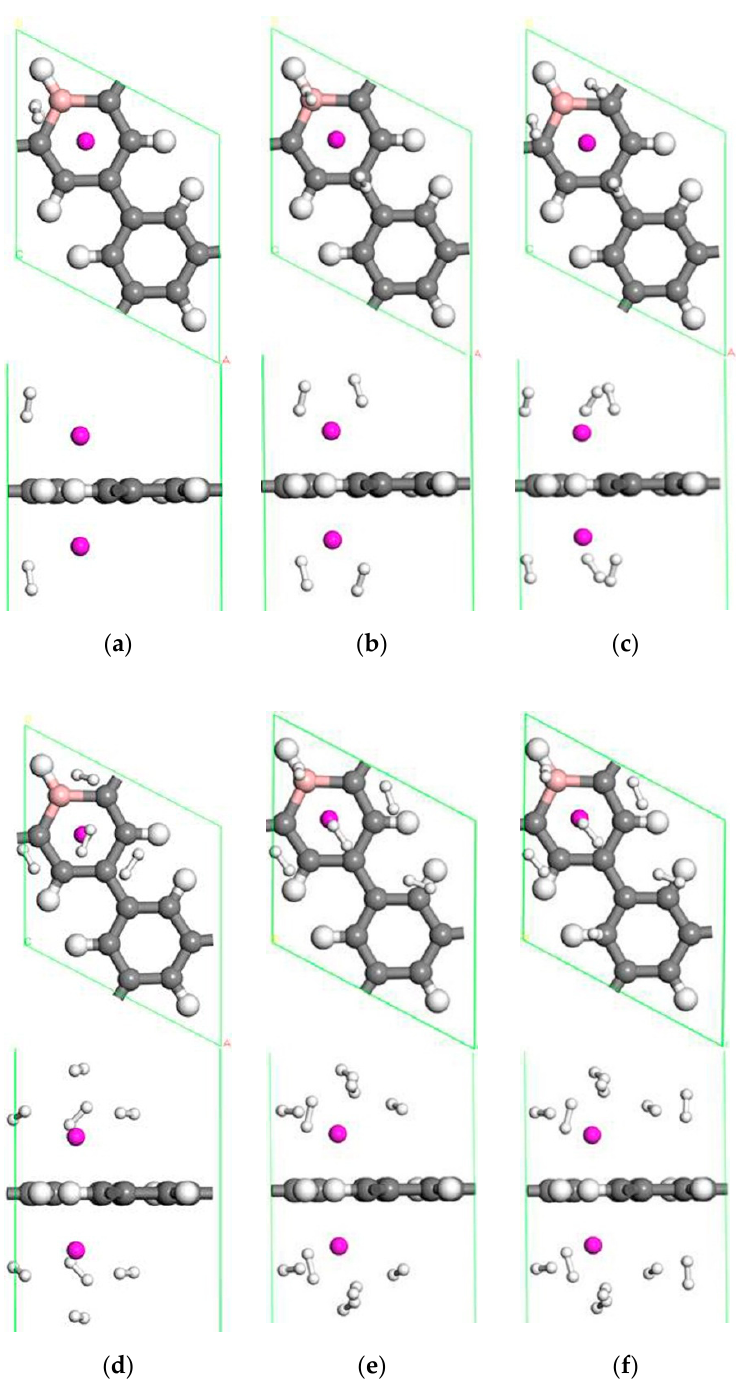
Figure 9. Optimized geometries of two Sc double-sided modified B-PG systems with two H2 molecules ( a ), four H2 molecules ( b ), six H2 molecules ( c ), eight H2 molecules ( d ), ten H2 molecules ( e ), and twelve H2 molecules ( f )